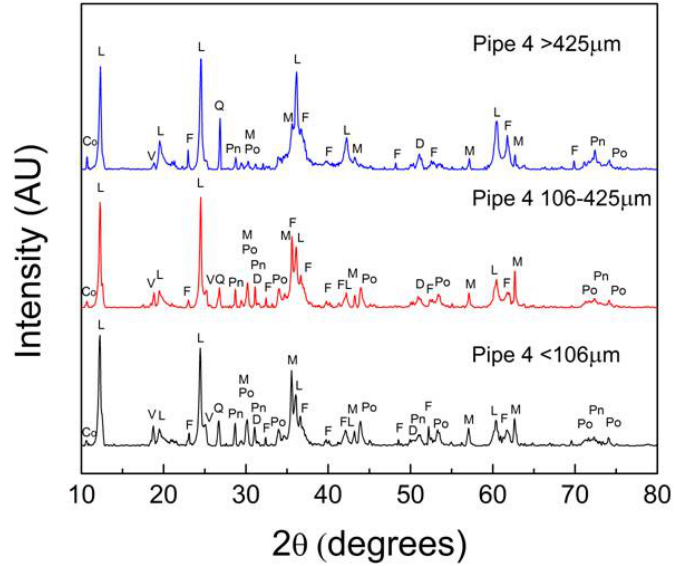
Figure 9. XRD patterns for Pipe ore microwave treated for 4 min, attrition milled for 15 min, and sieved into <106 µm, 106–425 µm, and >425 µm size fractions. Mineral phases identified include: cordierite (Co), dolomite (D), forsterite (F), lizardite (L), magnetite (M), pentlandite (Pn), pyrrhotite (Po), quartz (Q) and vermiculite (V).